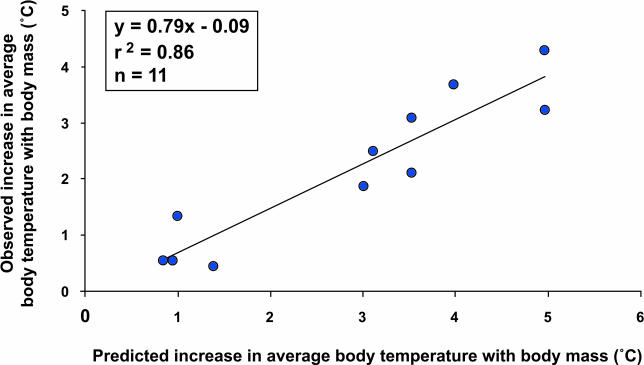
A Plot of the Observed versus the Predicted Increase in Average Body Temperature (°C) with Body Mass for CrocodilesThe observed increase in average body temperature for crocodiles ranging in mass from 32–1,010 kg [
5] was plotted versus the predicted increase in average body temperature with body mass for these crocodiles based on the line fit to the dinosaur data shown in
Figure 1 and predicted from
Equation 2.